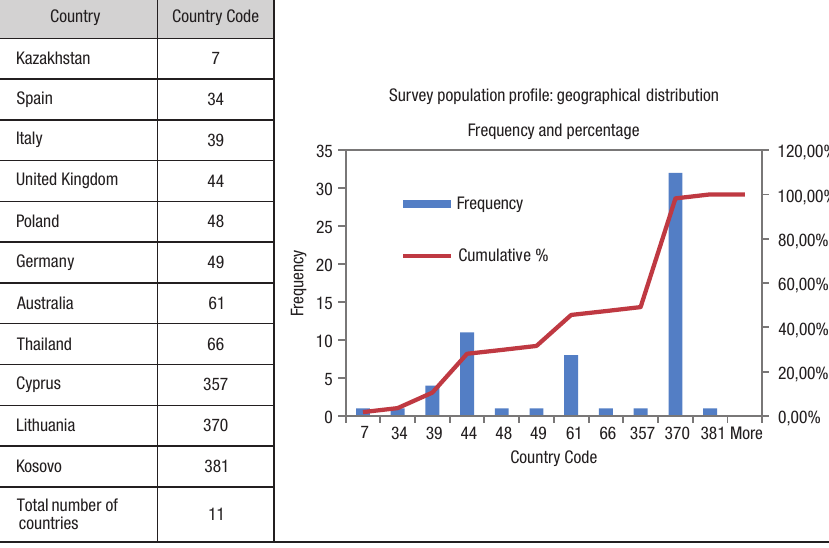
Fig. 4. Profile of the sample population: distribution by countries